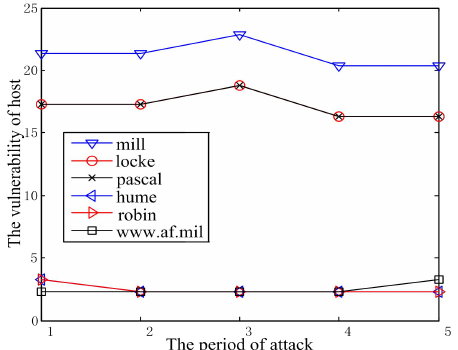
Figure 6: The threat of hosts in different period